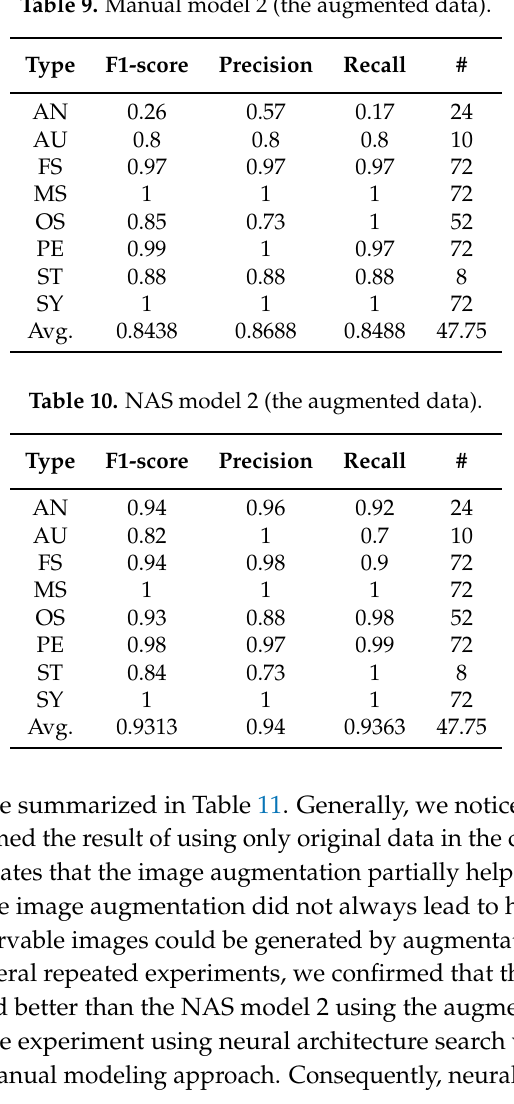
Table 9. Manual model 2 (the augmented data).